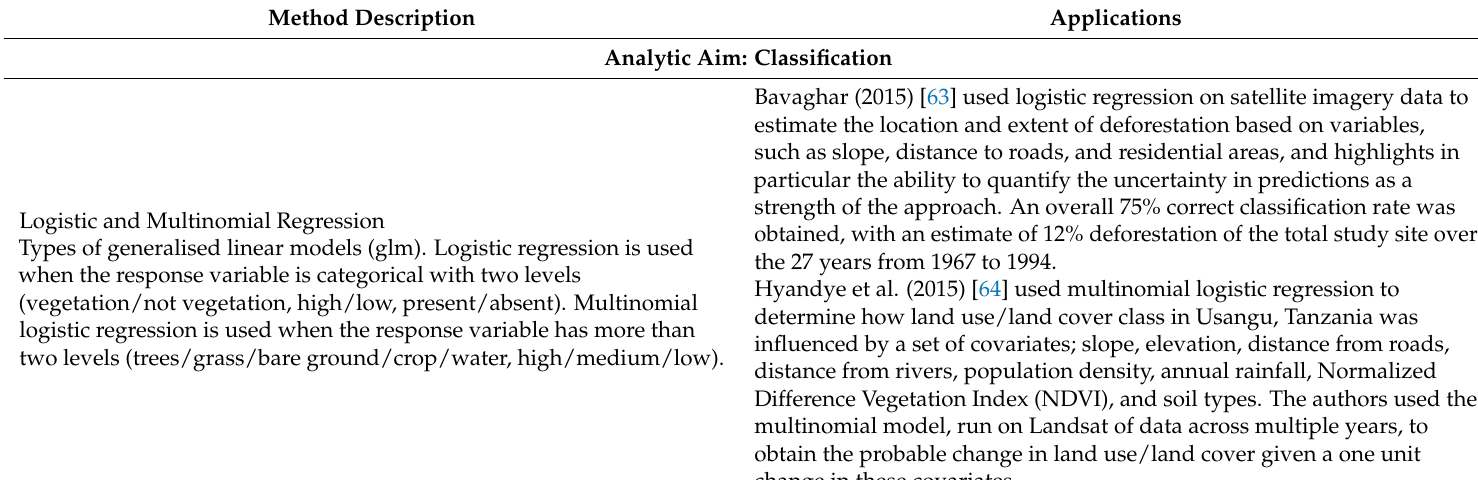
Table 2. Summary of methods for remote sensing data analysis and